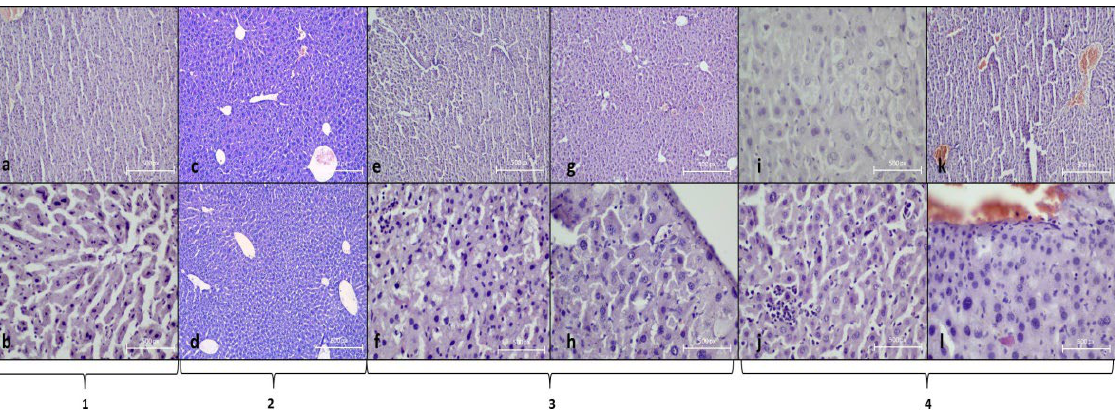
Figure 1. 1—control mice; 2—group protected with A. indica ; 3—group protected with A. indica in combination with OTA; 4—treated with OTA only; ( a ) normal appearance of the liver without significant pathological changes ( × 100); ( b ) normal appearance of the liver without significant pathological changes ( × 400); ( c ) normal appearance of the liver without significant pathological changes ( × 100); ( d ) normal appearance of the liver without significant pathological changes ( × 200); ( e ) mild degenerative changes in hepatocytes ( × 100); ( f ) weak mononuclear infiltrate and mild degenerative changes in hepatocytes ( × 400); ( g ) mild vascular congestion ( × 100); ( h ) area with hepatocytes with marked karyomegaly and mild degenerative changes in hepatocytes ( × 400); ( i ) pronounced degenerative and necrotic changes in hepatocytes ( × 400); ( j ) moderate mononuclear inflammatory infiltrate ( × 400); ( k ) markable vascular congestion ( × 100); ( l ) area with hepatocytes with karyomegaly and polychromasia, part of a vessel with vascular congestion (×400).